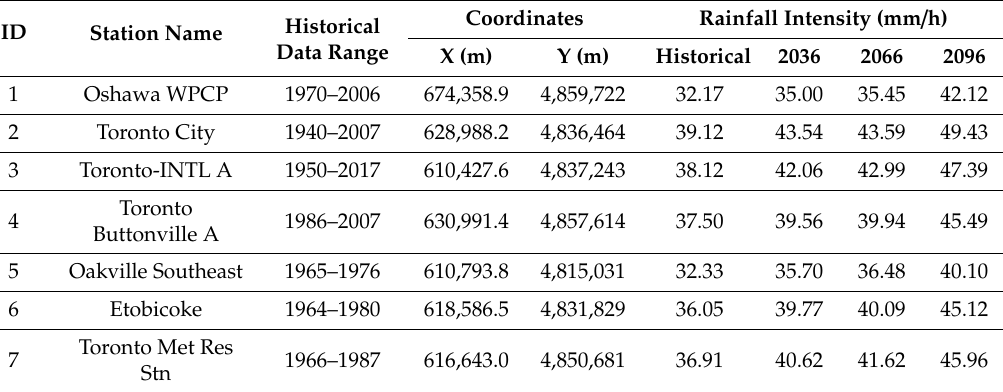
Table 1. Projected rainfall intensity for Toronto for Scenarios 2036, 2066, and 2096 [51,55], 60 min duration, and 10-year RP. The coordinates are in NAD_1983_UTM_Zone_17N.